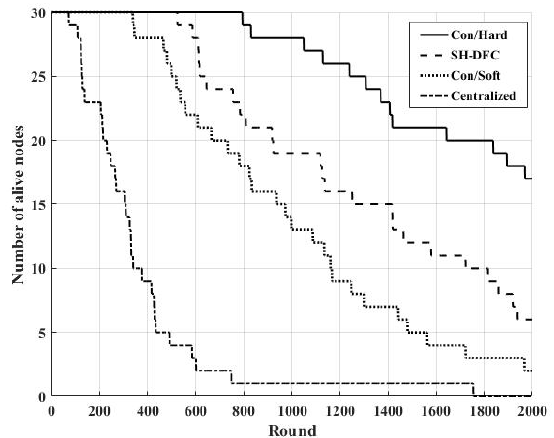
Figure 7. The number of alive nodes versus the round.